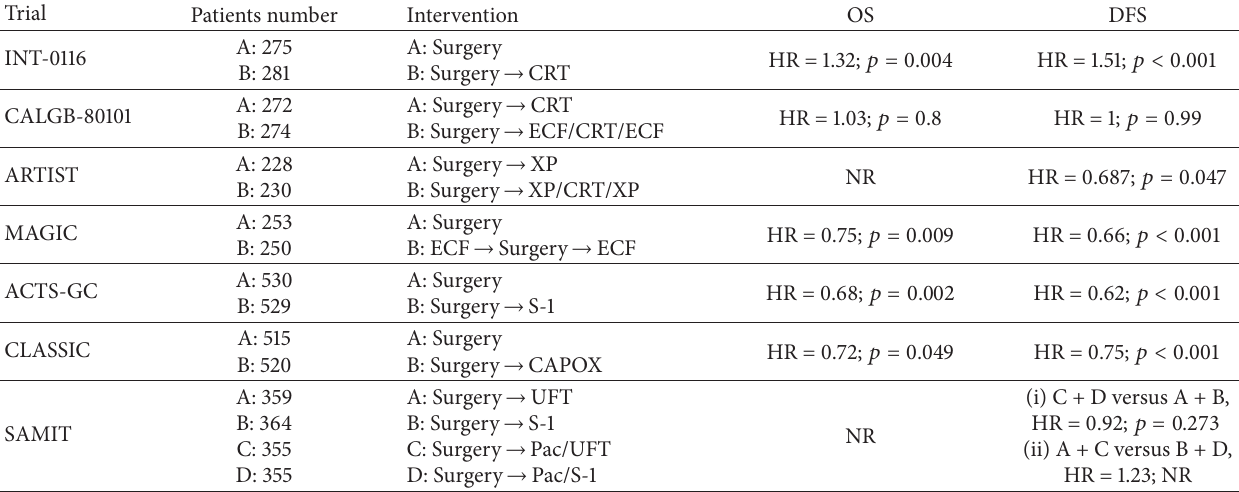
Table 1: Trials of curative strategy for gastric